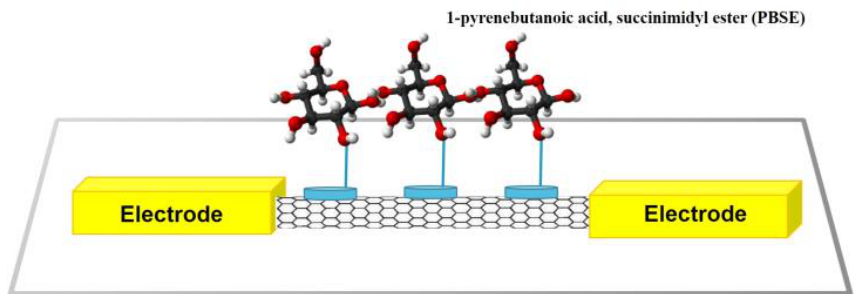
Figure 3. Noncovalent bond-based functionalization of SWCNTs using 1-pyrenebutanoic acid, succinimidyl ester (PBSE) [64,65].